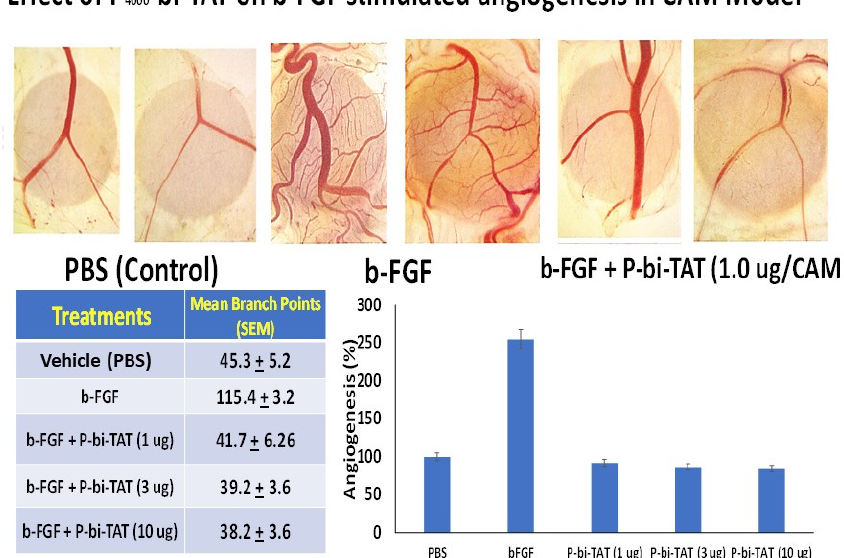
Figure 6. Angiogenesis assay results from chick chorioallantoic membrane (CAM) model demonstrate the inhibitory effect of P-bi-TAT on blood vessel formation induced by bFGF. Top panel of images shows representative CAM angiogenesis fields (in duplicates) of the PBS control, bFGF-induced blood vessel growth and lack of bFGF-induced blood vessel growth in the presence of P-bi-TAT. Bottom images report the inhibitory effect of the P-bi-TAT on bFGF-induced angiogenesis documented in a tabular format (Mean ± SEM) and the quantitative visualization of results as bar graphs. Pro-angiogenic bFGF concentration was 1 µg/mL in PBS.